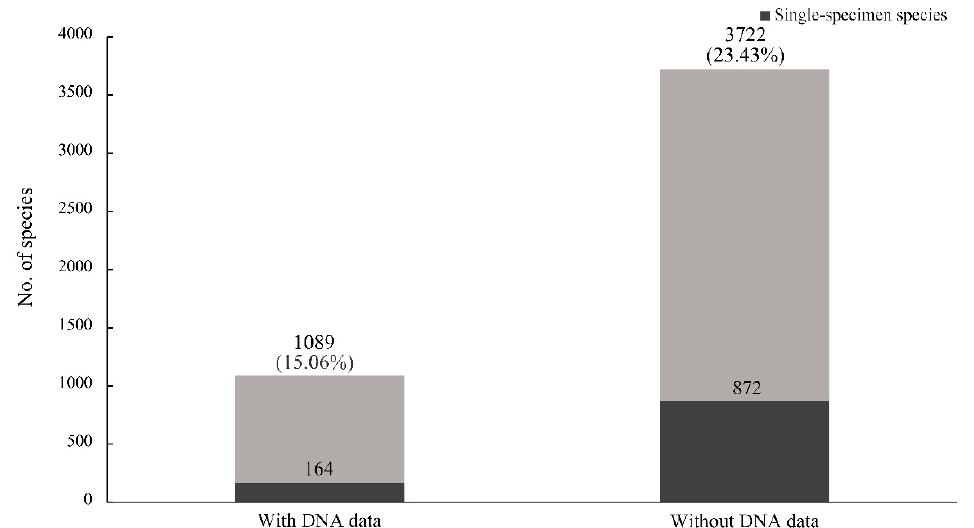
Figure 5. Relative proportions of single-specimen species (dark gray) from papers with DNA data versus that without DNA data in species description. The total numbers of species described in these papers and the percentages of single-specimen species are indicated before and in parentheses.